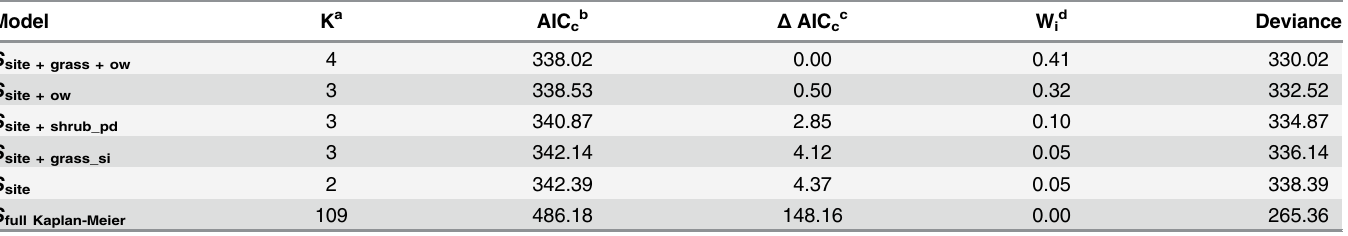
Table 4. Top-ranked survival models relative to fully saturated Kaplan-Meier model for neonatal pronghorn from birth to 31 August in western South Dakota, USA, 2002 – 2005 from intrinsic and habitat covariates when ^ c (model overdispersion term) was 1.0 (i.e., assumes data are not